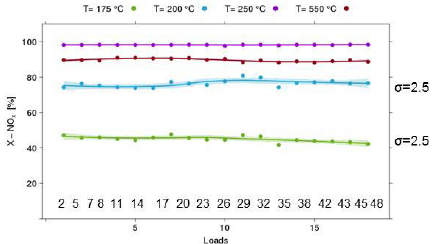
Figure 8. Results of validation experiments on the equivalence of channels (example: 18 loads of the selective catalytic reduction (SCR) Cu-Chabazite catalyst, 120 mg/reactor, 500 ppm NO, 500 ppm NH 3 , GHSV 70 kh − 1 ).